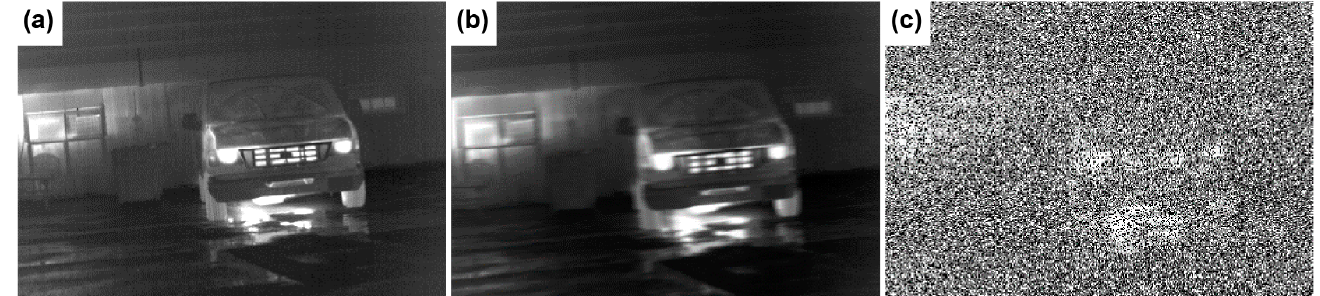
Figure 6. The truck image with different degrees of degradation. ( a ) The original image, ( b ) the 7 × 7 motion blur, and ( c ) the 7 × 7 motion blur + 50% salt-and-pepper noise.